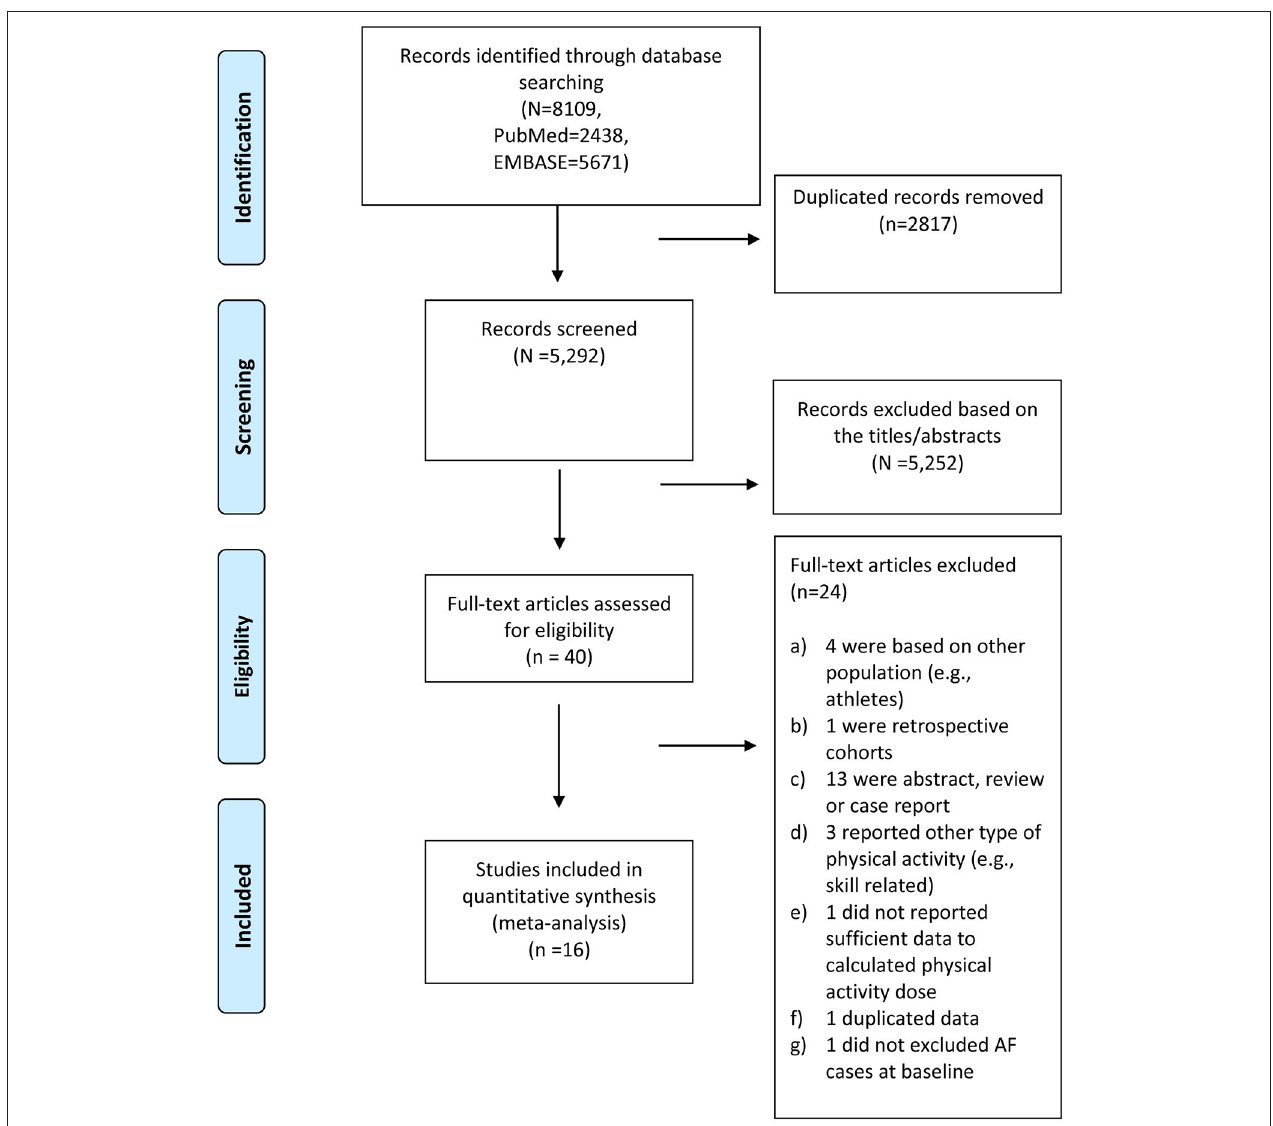
FIGURE 1 | Flow chart of study selection for our dose–response